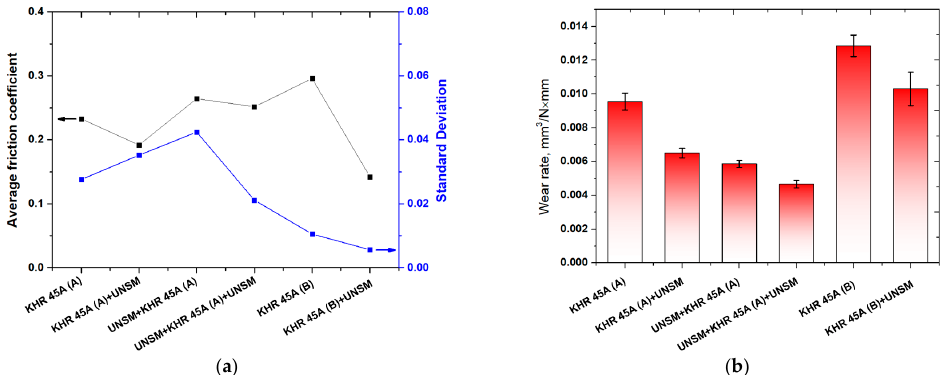
Figure 6. Comparison of the average friction coefficient along with the standard deviation ( a ) and wear rate ( b ) of the carburized, pre-, and post-carburized UNSM-treated KHR 45A